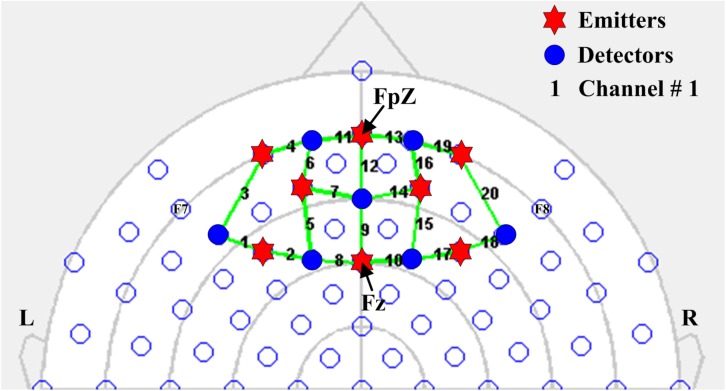
Configuration of fNIRS optodes on the prefrontal cortex considering FpZ as a reference point in accordance with the international 10–20 system for EEG electrode placement. Blue circles and red hexagons represent detectors and emitters, respectively, and the numbers indicate fNIRS channels.